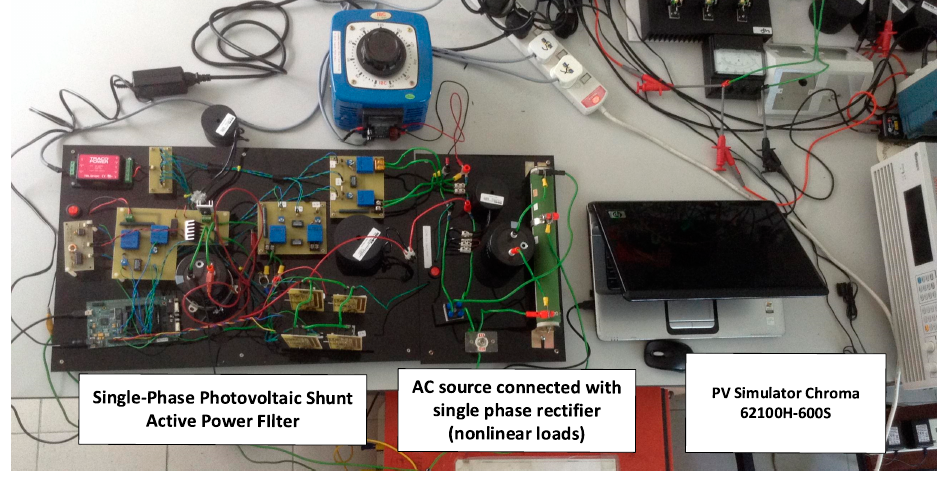
Figure 14. Experimental prototype of single-phase PV SAPF.